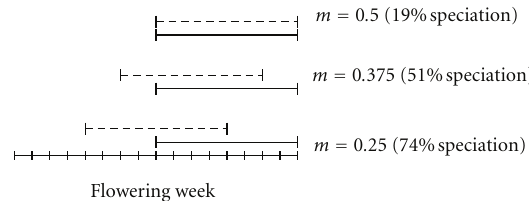
Figure 4: E ff ects of phenotypic plasticity of flowering time on ecological speciation. The lines illustrate flowering periods for plants on two soil types (dashed and solid) based on initial conditions in the simulations of Gavrilets and Vose [59] for ecological speciation based on the Howea palm tree study [60]. I illustrate the case where flowering time is a ff ected by 8 loci, and the environmental e ff ect of soil type is either 0, 2, or 4 weeks di ff erence. In the simulations [59], changing the number of loci has confounding e ff ects on the initial environmental variance component and the fitness e ff ects of mutations, so a single genetic scenario is illustrated here for simplicity. I calculated the initial rate of gene flow between soil types as m = 0.5 (% time overlap), based on the assumption that any tree is equally likely to receive pollen from any other currently flowering tree. %speciation is based on the number of simulations ending in speciation, given in Table 2 of Gavrilets and Vose